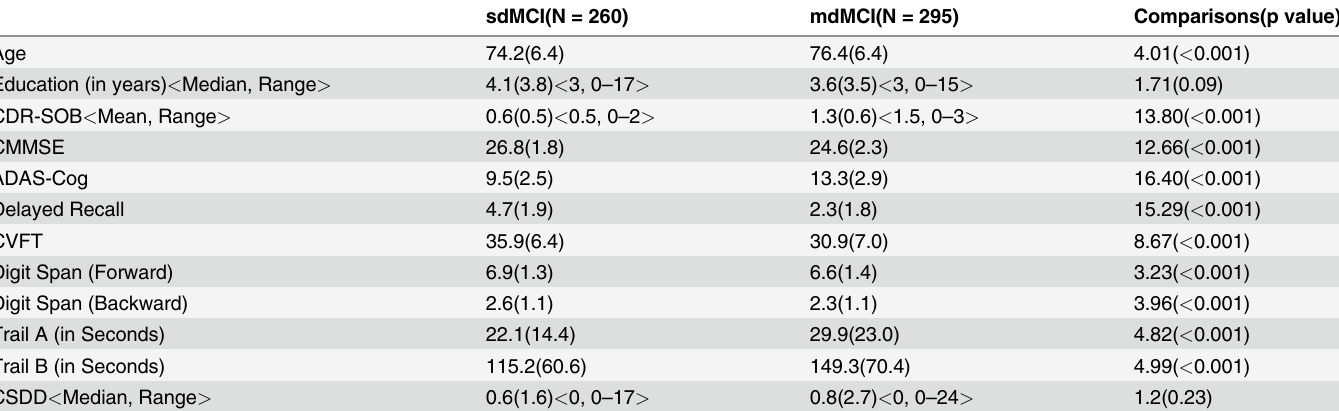
Table 2. Demographic and baseline cognitive profiles of sdMCI and mdMCI